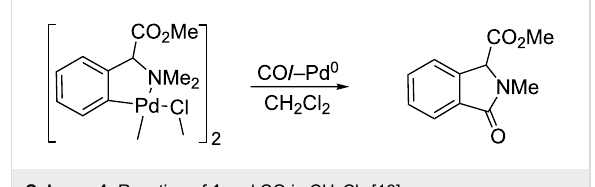
Scheme 4: Reaction of 1 and CO in CH 2 Cl 2